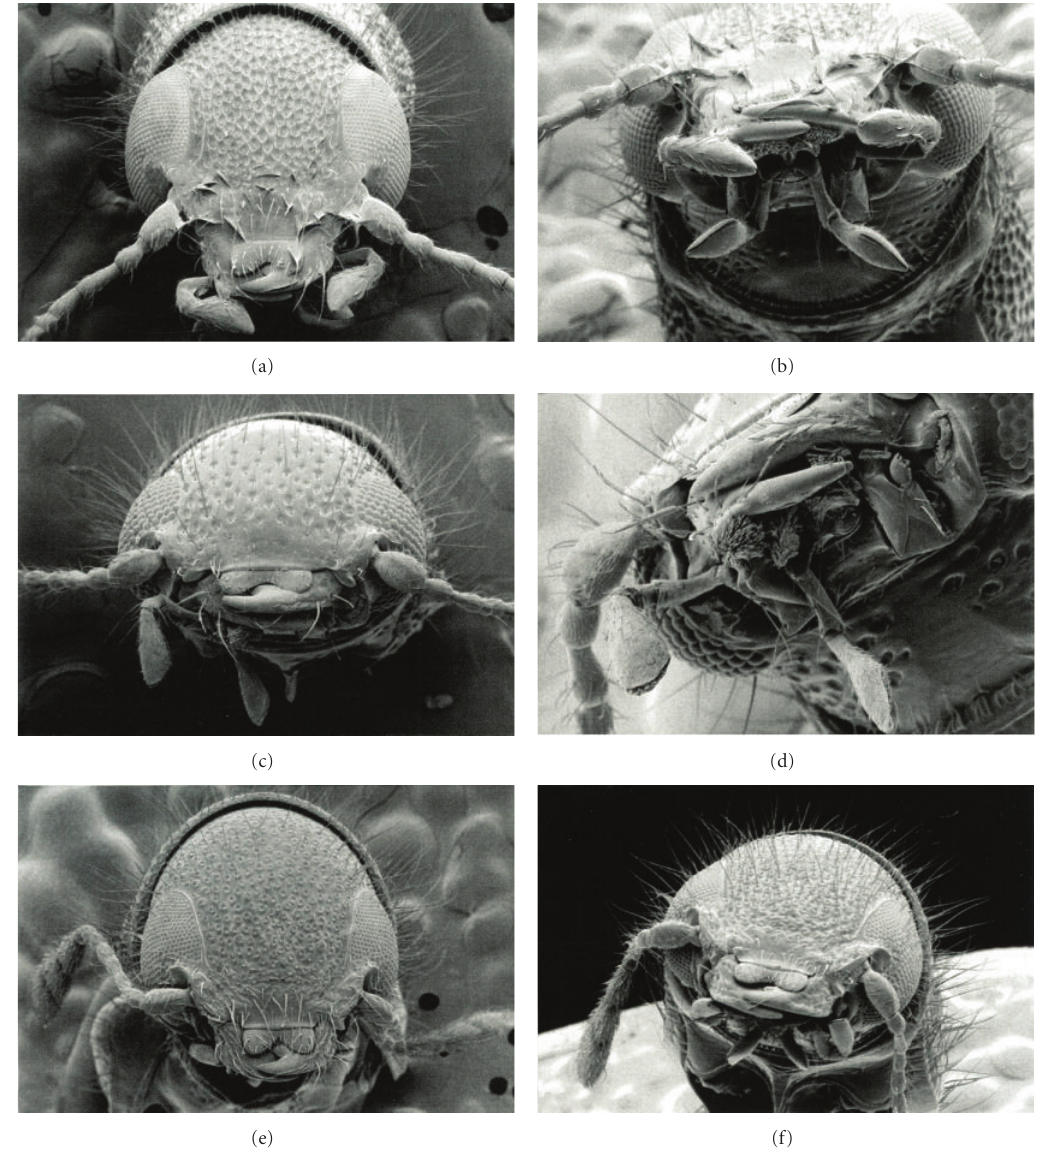
Figure 20: Various organs. (a, b) Tarsostenodes simulator ((a) head, (b) mouthparts). (c, d) Tarsostenus univittatus ((c) head, (d) mouth- parts). (d, e) Thriocera pectoralis ((d) head, (e) mouthparts). than length of abdomen, phallobase not reduced, lobate, lobes fimbriate; phallic lateral plates wide, phallobasic rod absent, phallic apex robust, spicular plates very narrow (Figure 17(h)), spicular apodemes fused, intraspicular plate rod shaped; ovipositor, ventral and dorsal laminae unilobed, laminal rod present; distal margin of pygidium not incised, distal margin of male 6th sternite slightly incised. Alimentary canal : not studied. Male mesodermal internal reproductive organs : not studied. Female mesodermal internal reproductive organs : spermathecal capsule tubular, well sclerotized, sper- mathecal gland attached to middle of spermathecal